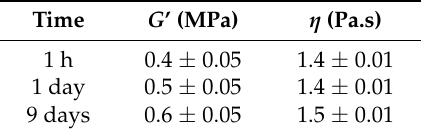
Table 2. Evolution in time of storage modulus and viscosity for PDMS RTV615.